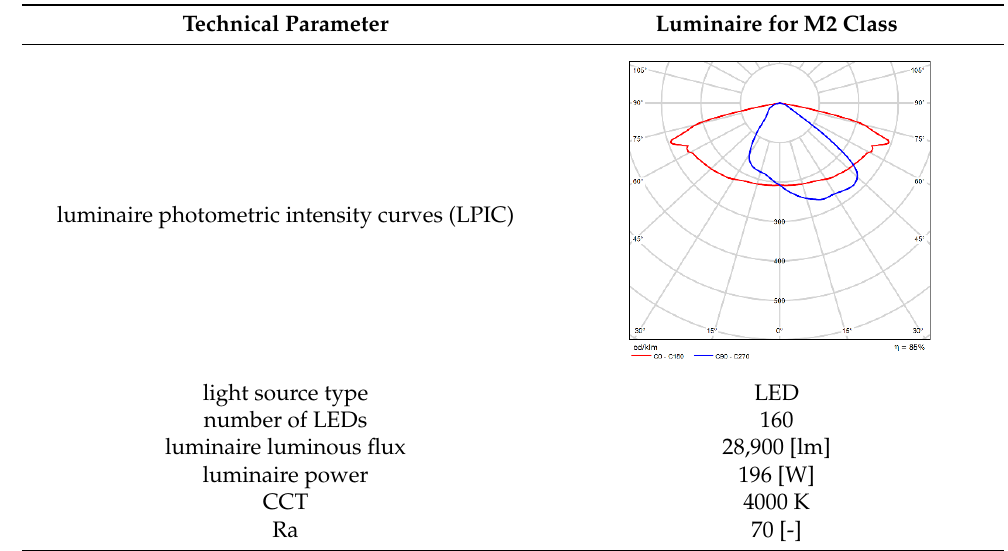
Table 5. Technical data for a luminaire fitted with high-power LEDs.